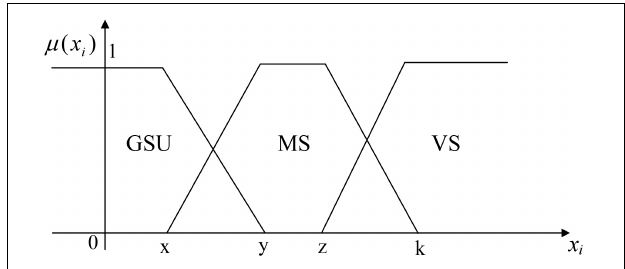
FIGURE 5 | Trapezoidal membership function of decision attribute δ .